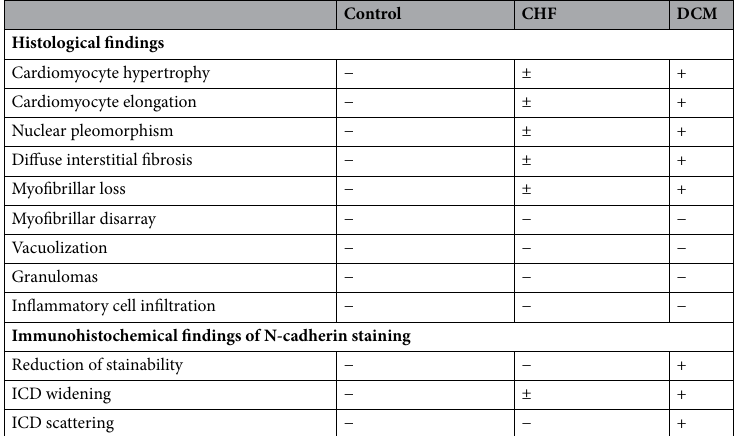
Table 2. Summary of pathological findings in three groups. Pathological and immunohistochemical findings from the control, CHF, and DCM groups are summarized in this table. Deterioration of N-cadherin immunostaining was defined as a reduction in immunostaining relative to the control group. Moreover, ICD widening was defined as a width of 4 µm or more, and ICD scattering as 15 µm or more. The meanings of the symbols used in this table are as follows: (−): This finding is absent in most cases. (±): This finding is present in some cases. (+): This finding is present in most cases. CHF chronic heart failure, DCM dilated cardiomyopathy, ICD intercalated